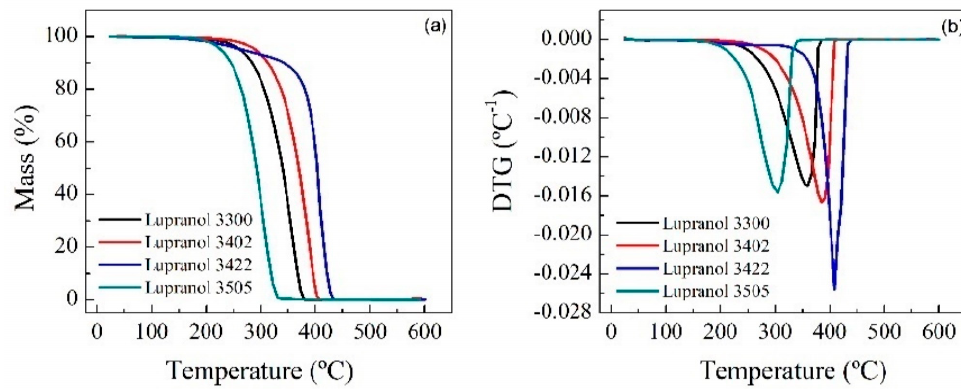
Figure 6. TG ( a ) and dTG ( b ) of reference polyols.